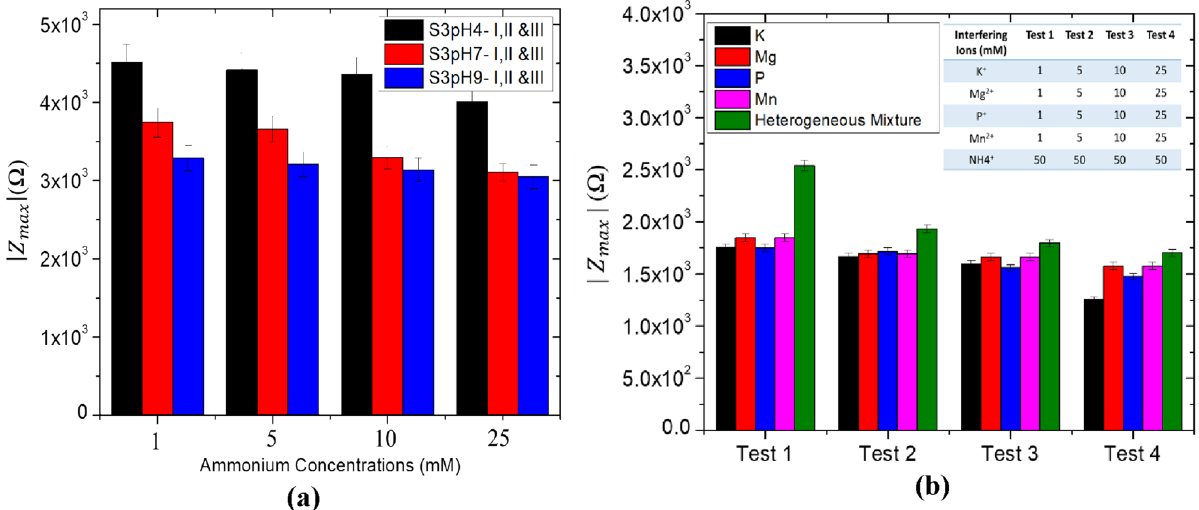
Figure 7. ( a ) | Z max | versus NH 4 + concentration (1–20 mM) for three similar set of S3 devices in acid, neutral and alkaline pH conditions. ( b ) Selectivity performance of the sensor in the presence of Interfering ions (K + , Mg 2+ , P + , Mn 2+ and Heterogeneous mixture) concentrations